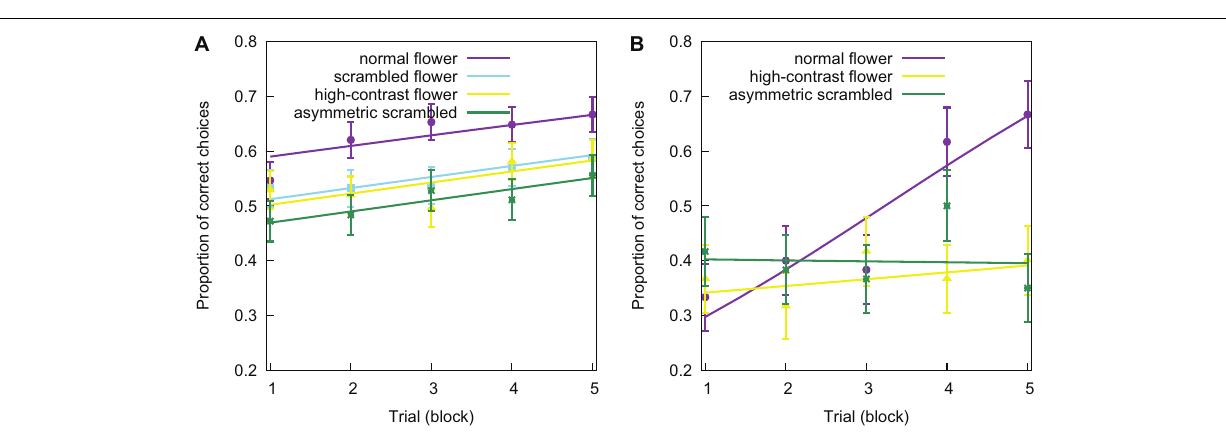
FIGURE 4 | Linear model (solid lines) and mean proportion of correct choices (markers) observed from a group of experienced (A) and naïve bees (B) . Different groups of bees were trained with differential conditioning to discriminate between two flower images in different configurations: normal flowers (purple line, circle markers), scrambled flowers (blue line, square markers), high contrast flowers (yellow line, triangle markers), and asymmetric scrambled flowers (green line, asterisk markers). Each training block represents the pooling of six choices following standard methods (Giurfa et al., 2001). Error lines represent the standard error of the mean proportion of correct choices for each trial block. The solid lines represent the fixed effects of the two